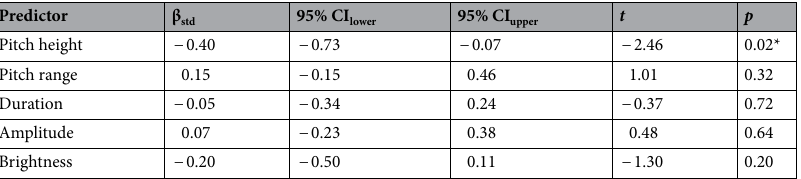
Table 1. Full linear model of mother’s voice acoustics predicting child’s age. *Statistically significant at α = 0.05; β std standardized beta, CI confidence interval. The table provides statistical values for a simultaneous multiple regression, in which all acoustical features are entered into the regression model at the same time. The standardized betas for each acoustical feature are interpreted in the context of the influence of all the other acoustical features.